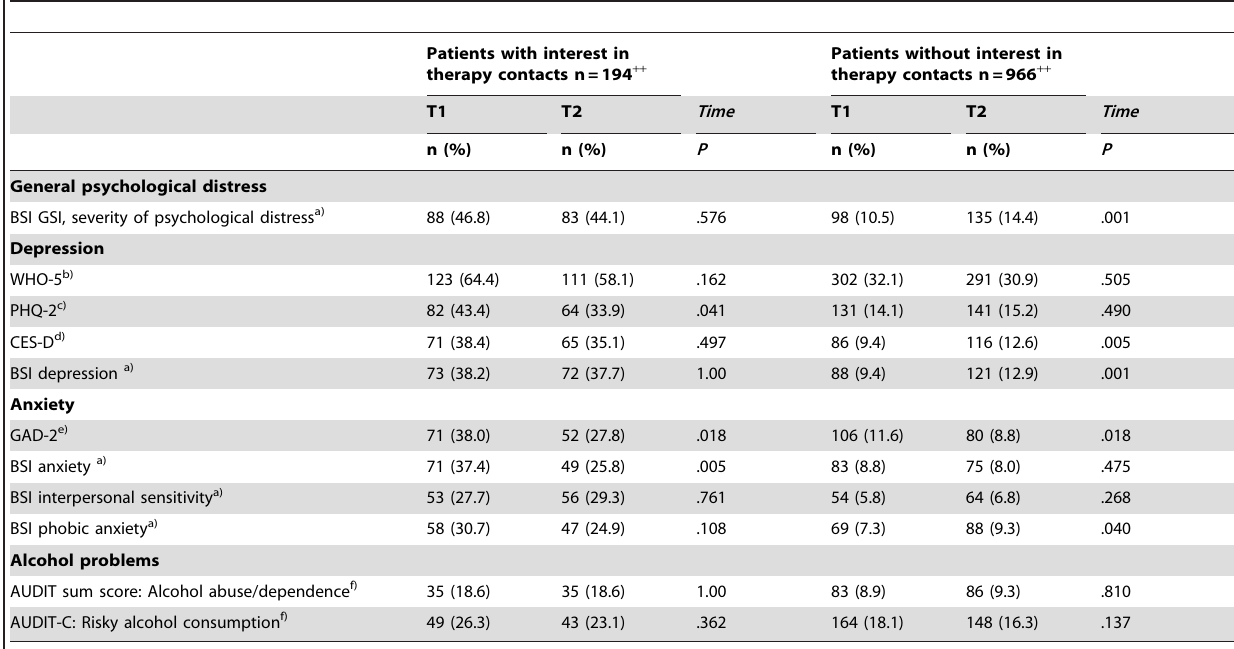
Table 5. 6-month follow-up of rates of clinically significant distress and alcohol use problems of surgical patients with interest in psychotherapy (n=193) and surgical patients without interest in psychotherapy (n=964). +